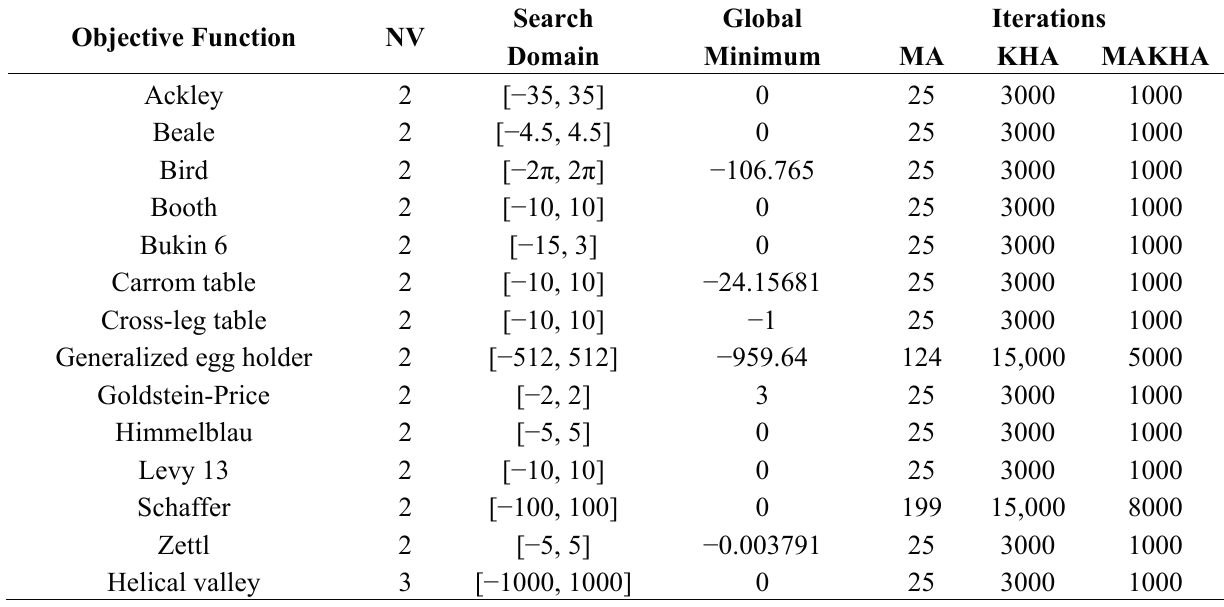
Table 2. Decision variables, global optimum of benchmark functions and number of iterations used for testing the performance of MA, KHA, and